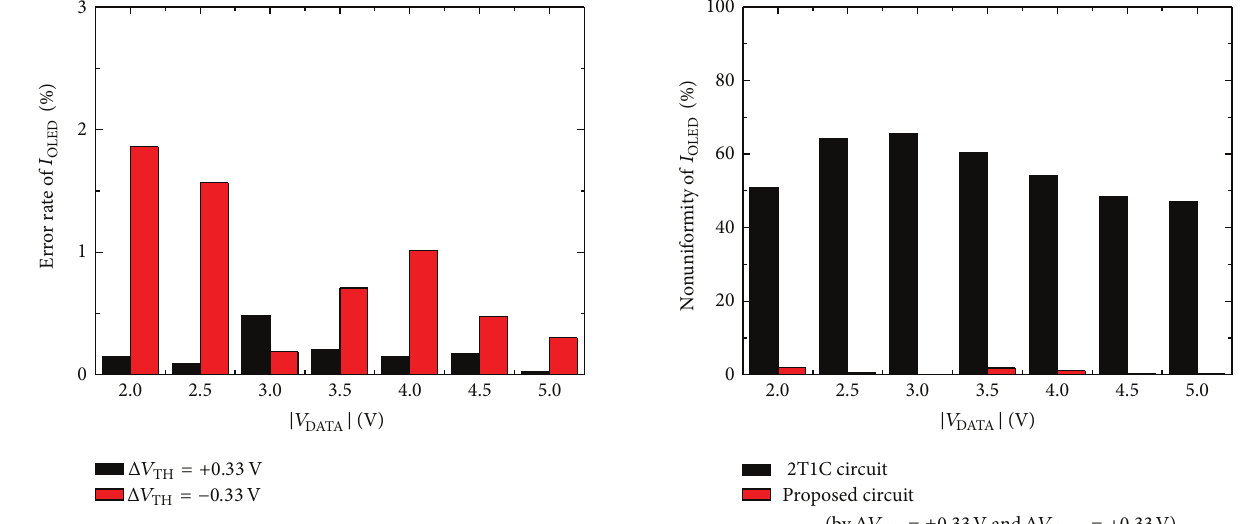
at different 𝑉 under the OLED DATA = +0.33 V). The average TH O